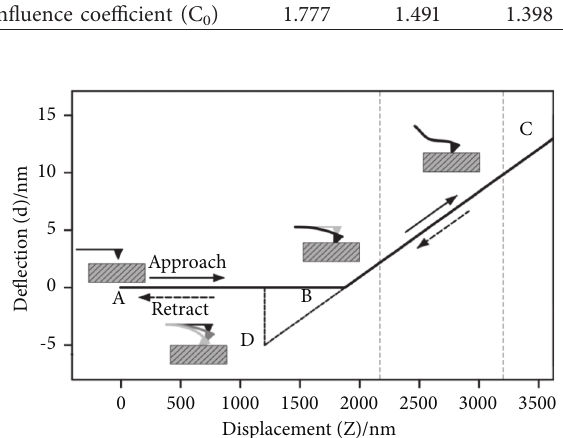
Figure 2: Force-displacement